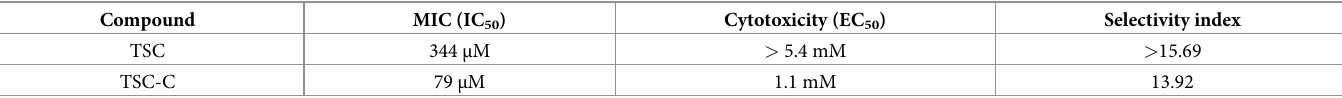
Table 1. Inhibitory and cytotoxic effects of TSC and TSC-C to P . brasiliensis and fibroblast cells, respectively.